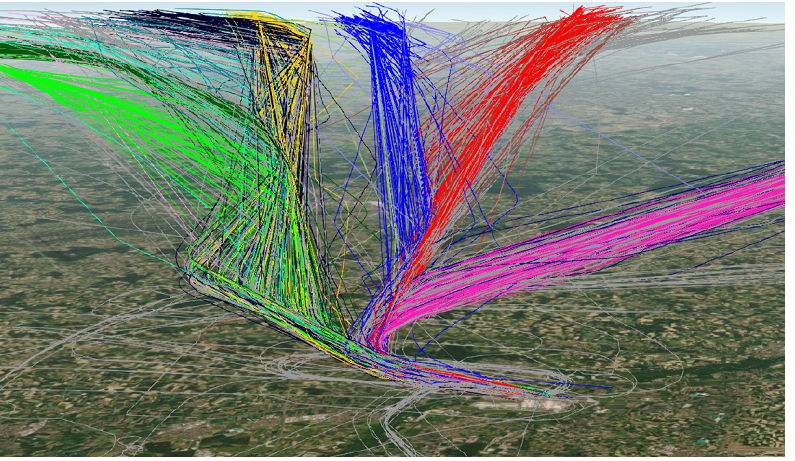
Figure 1. Clustered ADS-B radar tracks of departing flights using runway 26R at Munich Airport. Colors represent clusters where gray flights are